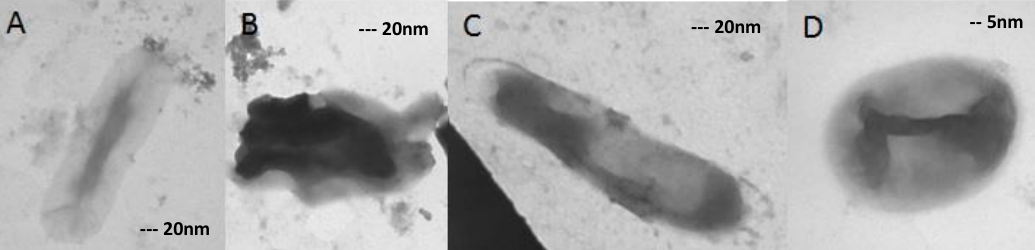
Figure 4. ( A–C ) 40,000 × magnified and ( D ) 100,000 × . The isolates were grown on 16 mg/L ofloxacin, and changes in morphology are clearly distinguishable.